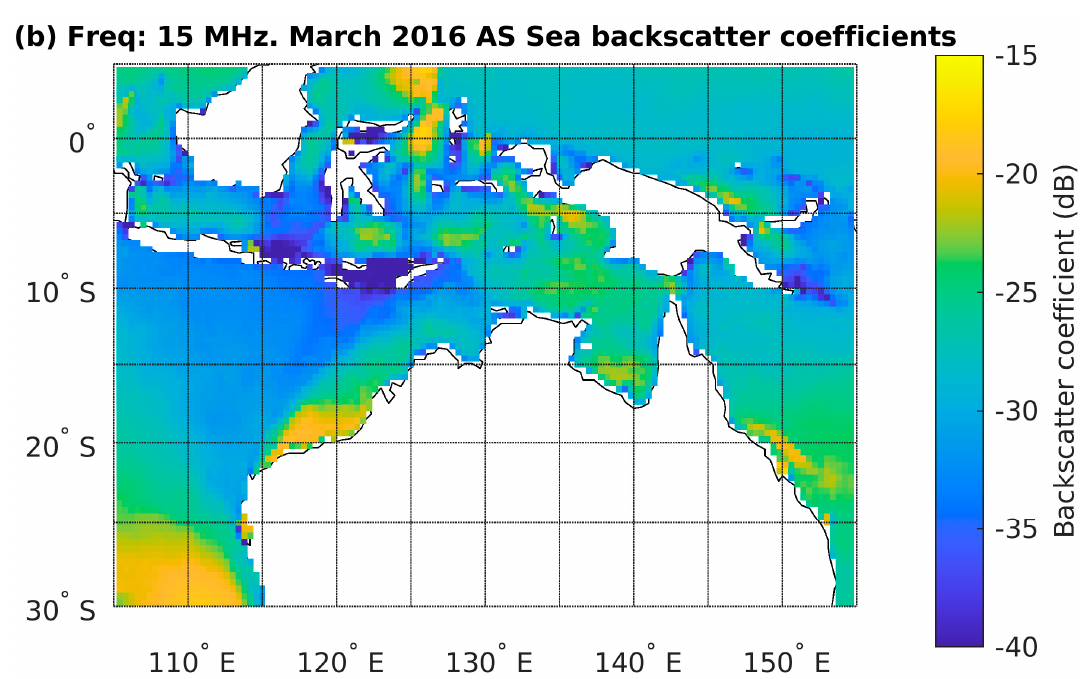
Figure 5. Monthly daytime median sea surface backscatter coefficients calculated with the Barrick method using a radiowave frequency of 15 MHz for a radar located at Alice Springs in ( a ) September 2015 and ( b ) March 2016. The 0.4° resolution sea state data were used to calculate the JONSWAP spectrum.